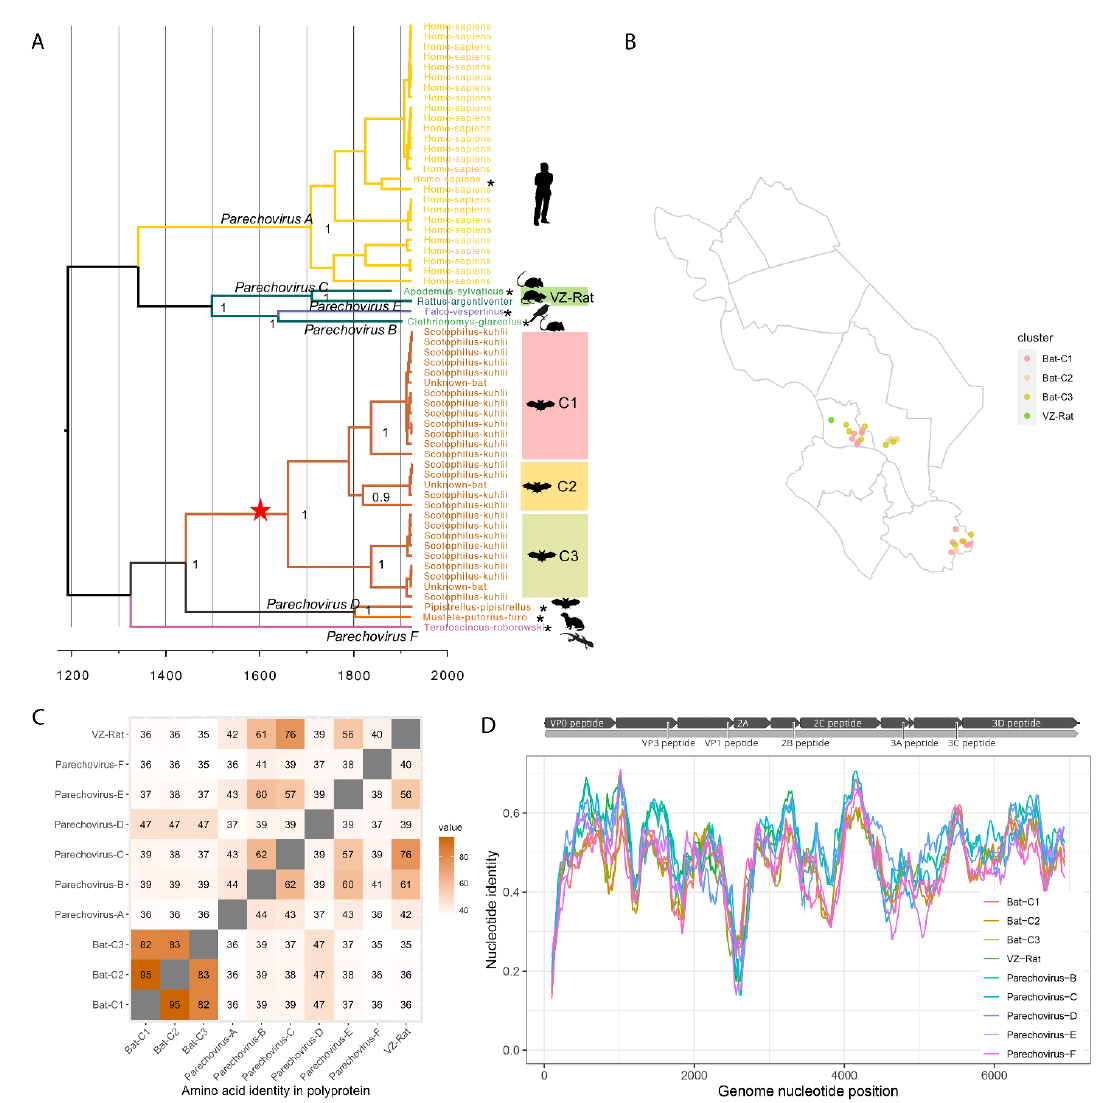
Figure 6. Parechovirus sequences in bats, rats, and other hosts. ( A ) Simplified MCC tree representing the time-scale phylogeny of parechoviruses. Bayesian time-scaled tree of VP1 sequences detected in Vietnamese rats and reference sequences in NCBI (highlighted in asterisk). Currently identified species in the genus Parechovirus are labelled on the nodes. Different host species are indicated on the tips and distinct by colours and symbols; sequences from a Vietnamese rat (Parechovirus|VZ-Rat) and the clusters (Parechovirus|Bat-C1 to C3) found in Vietnamese bats are labelled on the right; the internal node of the putatively novel species found in bats is highlighted with red star. ( B ) Locations of bat and rat samples with parechovirus sequences, coloured by different clusters identified in the phylogenetic tree. ( C ) Genetic identities in polyprotein among bat and rat sequences found in Vietnam comparing to reference sequences of species in the genus Parechovirus . ( D ) Genetic distance scan across the entire polyprotein coding region of bat clusters and rat sequence found in Vietnam, comparing to reference sequences of Parechovirus A .